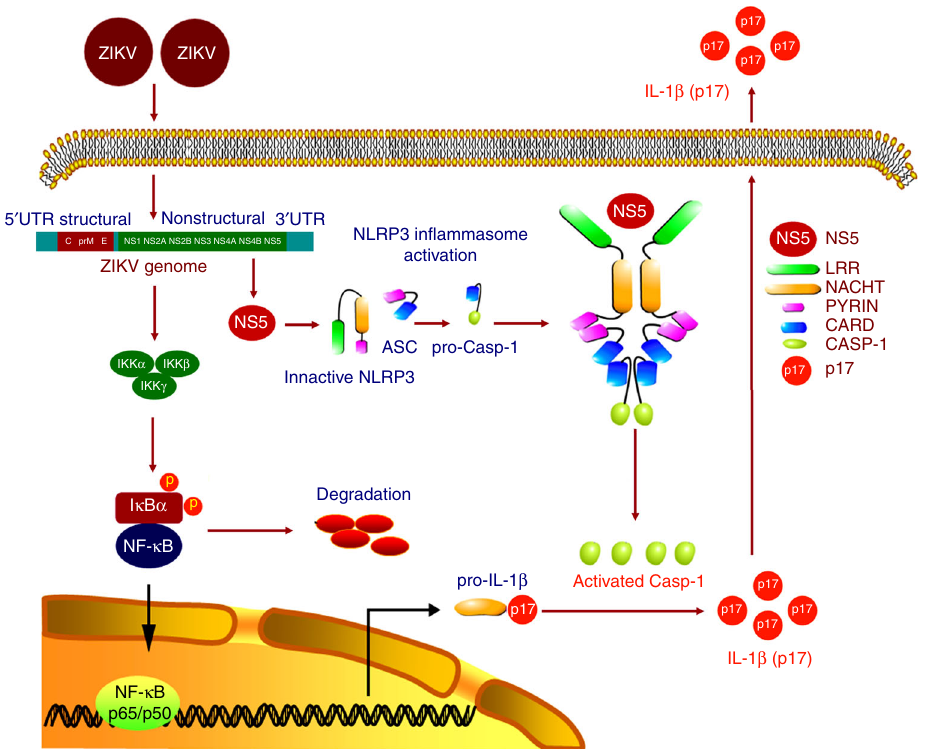
Fig. 9 A proposed novel mechanism by which ZIKV infection induces in fl ammatory responses. During ZIKV infection, the viral NS5 protein activates the NLRP3 in fl ammasome by directly binding to NLRP3. The binding of NS5 to NLRP3 facilitates the assembly of NLRP3 in fl ammasome complex by forming a sphere-like structure of NS5-NLRP3-ASC. The activation of NLRP3 in fl ammasome promotes pro-Casp-1 cleavage, leading to the secretion of IL-1 β . Then IL-1 β plays crucial roles in host innate immunity by inducing host in fl ammatory